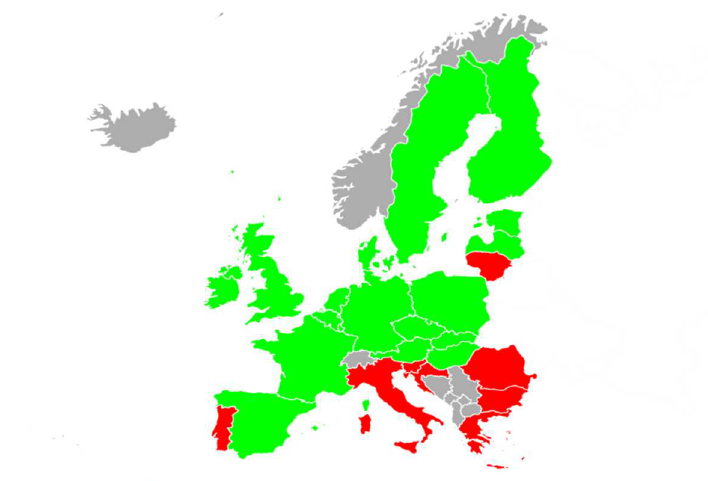
Figure 1: Start-up and Silicon Valley